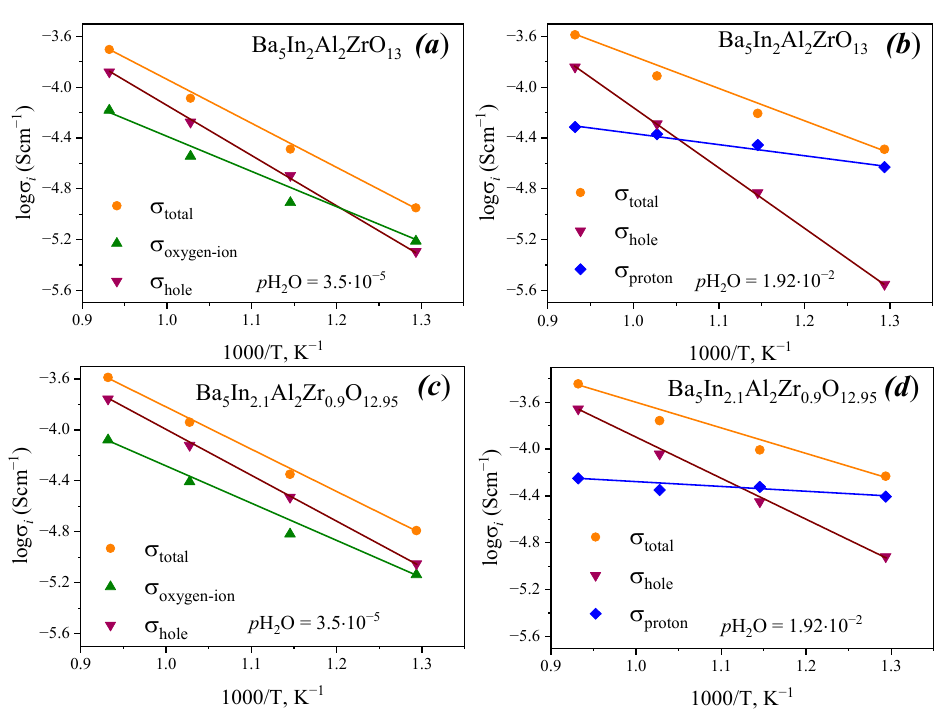
Figure 13. Partial conductivities for Ba 5 In 2 Al 2 ZrO 13 in dry ( a ) and wet ( b ) atmospheres, and for Ba 5 In 2.1 Al 2 Zr 0.9 O 12.95 in dry ( c ) and wet ( d ) atmospheres. Ba 5 In 2.1 Al 2 Zr 0.9 O 12.95 in dry ( c ) and wet ( d ) atmospheres.